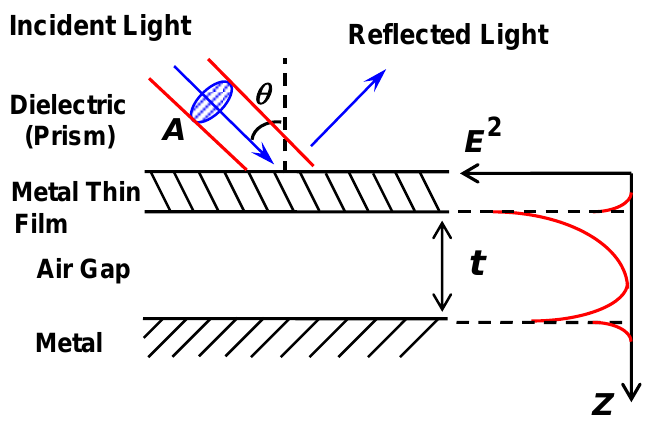
Figure 1. Schematic illustration of the metal enhanced-evanescent-wave